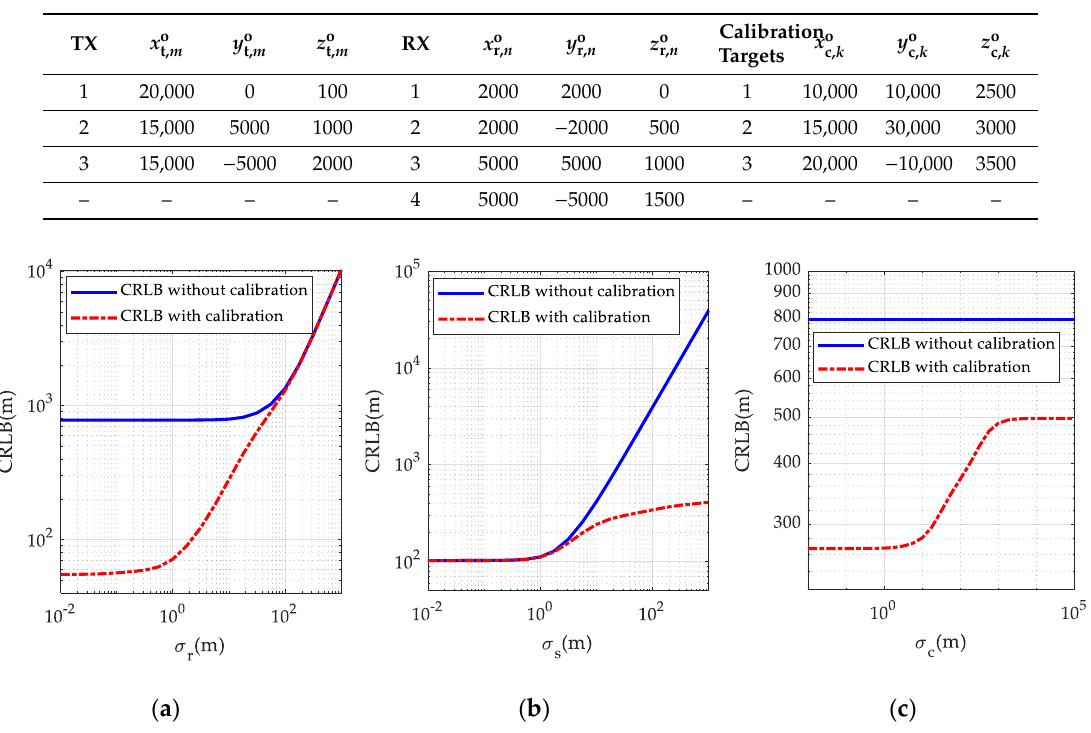
Figure 3. Comparison of the CRLBs with and without using calibration targets: ( a ) for di ff erent BR measurement noise level σ r ; ( b ) for di ff erent transmitter / receiver position error level σ s ; ( c ) for di ff erent calibration target position error level σ c .